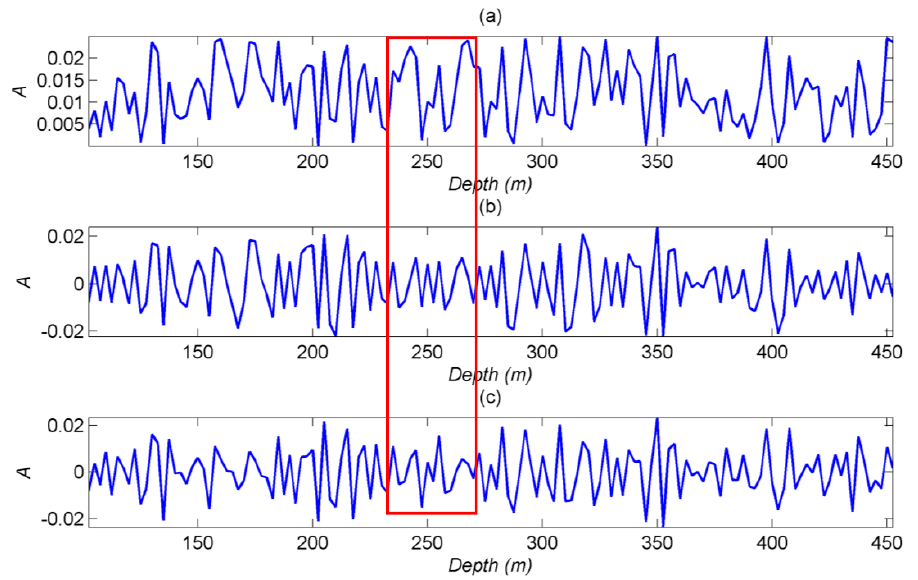
Figure 7. White Gaussian noise and IMF1: (a) white Gaussian noise, (b) IMF1 of EMD, (c) IMF1 of CEEMD.